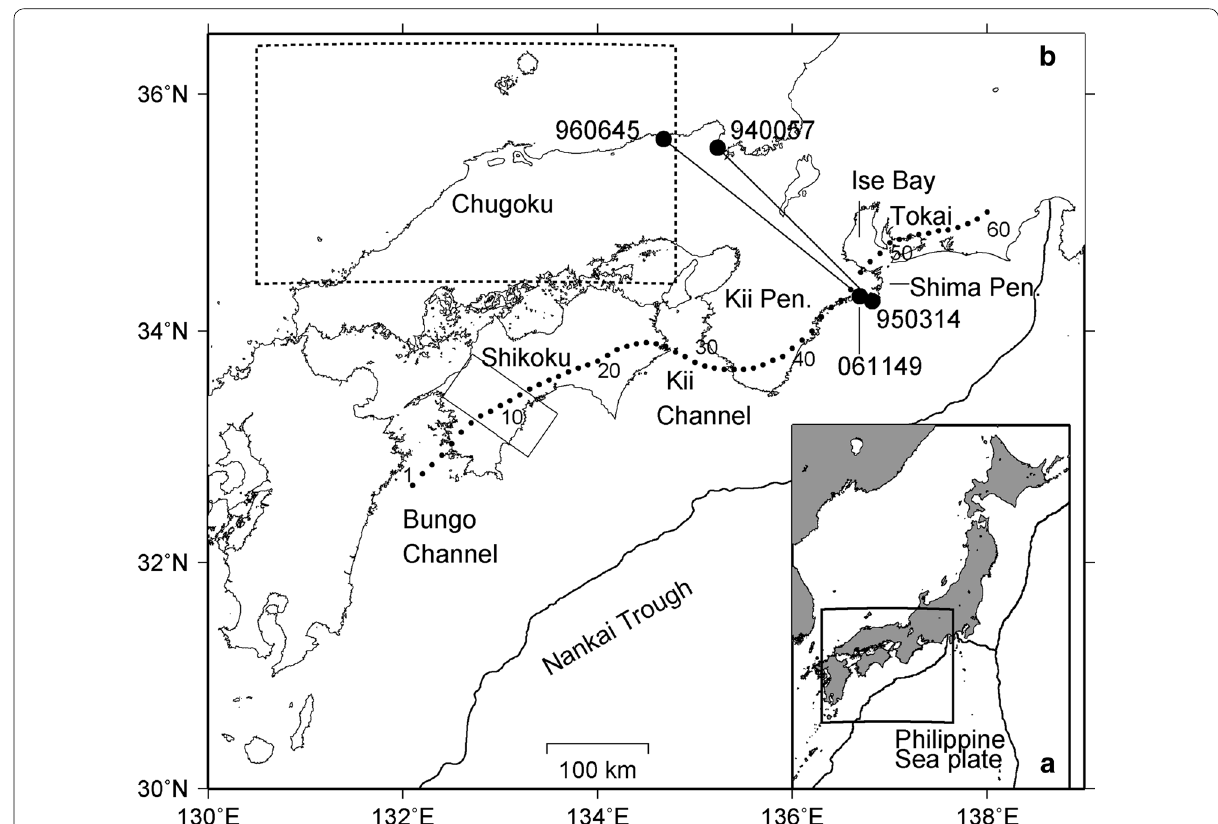
Fig. 1 Map of the study area in southwest Japan. a Location and plate tectonic setting. Heavy curves here and on the main map indicate plate boundaries. b Locations in the Nankai Trough study area. The dashed rectangle encloses the fixed region. Large numbered dots indicate GNSS stations. Heavy lines connecting two stations represent baselines for measurement of length changes. Small dots numbered 1–60 show the approximate location of the 25 km depth contour on the Nankai Trough subduction interface. The oblique rectangle in western Shikoku indicates an example of 100 km 50 km area centered on dot ×